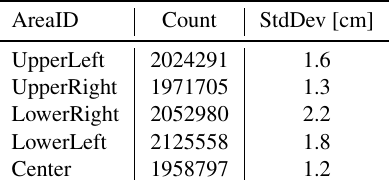
Figure 7. Controlled light conditions (left), no extraneous light (right)